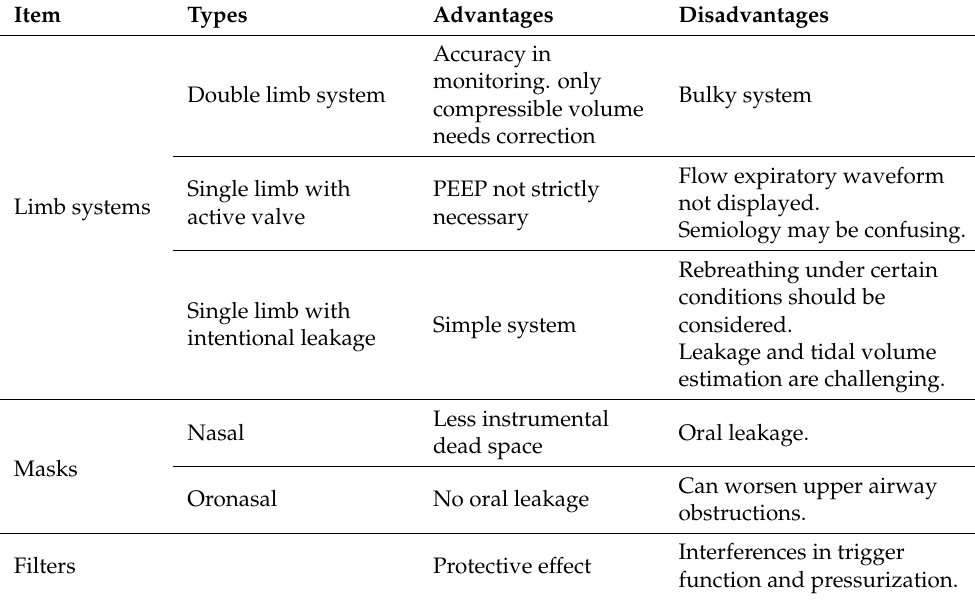
Table 1. Summary of advantages and disadvantages of each type of